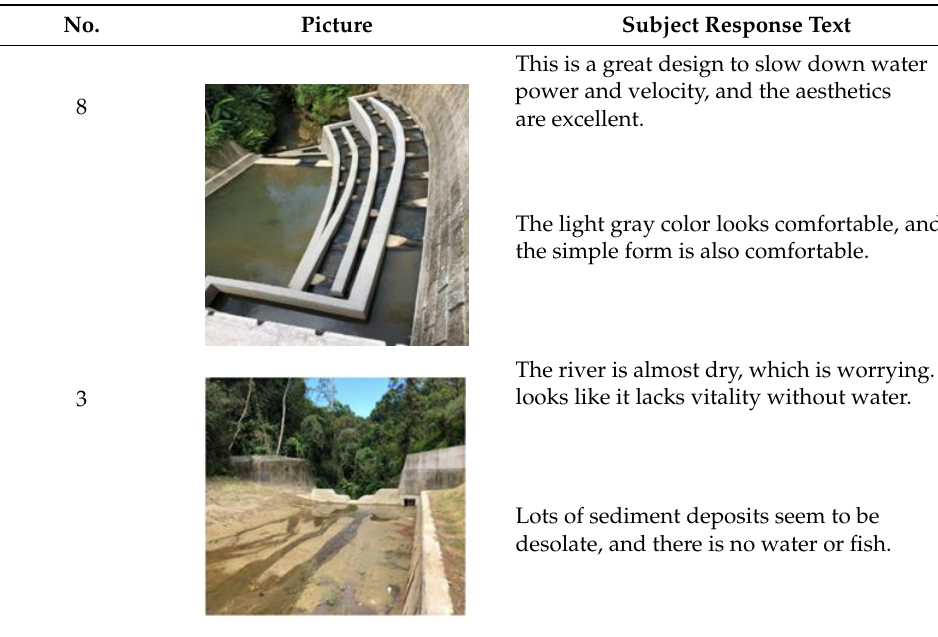
Table 11. CEM comparison of the highest and lowest SBE value images of the “Renovation Project of Sijiaolin Stream”.